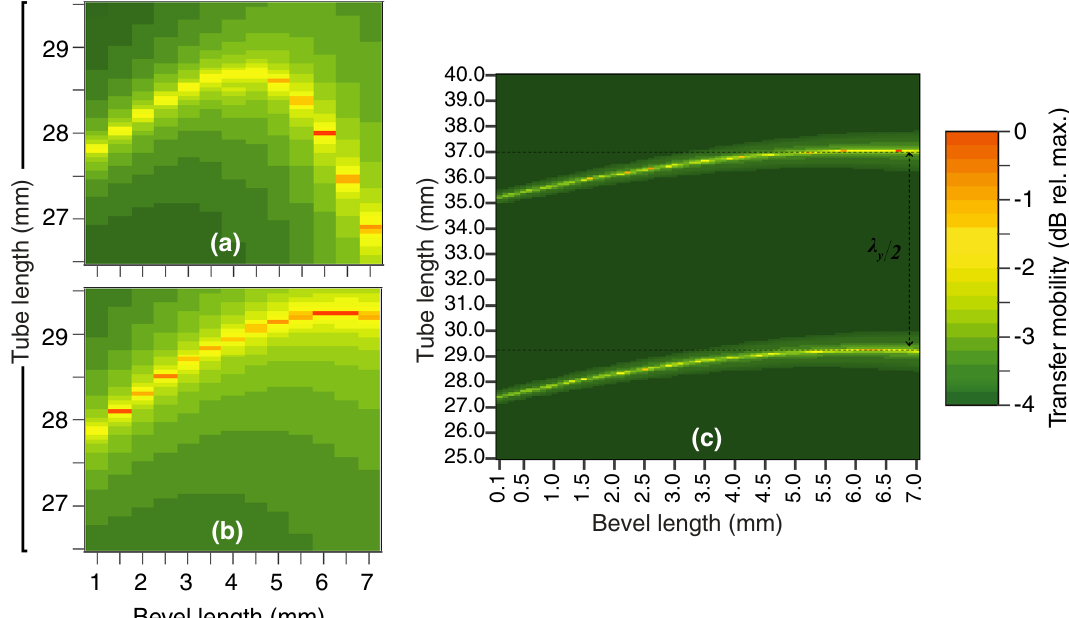
Figure 9. FEM parametric studies at 29.75 kHz, revealed that the transfer mobility for axi-symmetric tip was less influenced by the change in tube length than its a-symmetric counterpart. Bevel length (BL) versus tube length (TL) studies for a-symmetric ( a ) and axi-symmetric ( b , c ) bevel geometries, in a frequency domain study employing FEM (boundary conditions as in Fig. 2). ( a , b ) TLs range was 26.5–29.5 mm (step size 0.1 mm) and BLs 1–7 mm (step size 0.5 mm). ( c ) An extended axi-symmetric bevel study included TLs 25–40 mm (step size 0.05 mm) and BLs 0.1–7 mm (step size 0.1 mm), which revealed the (cid:31) y / 2 relationship required to satisfy the freely-moving boundary condition at the